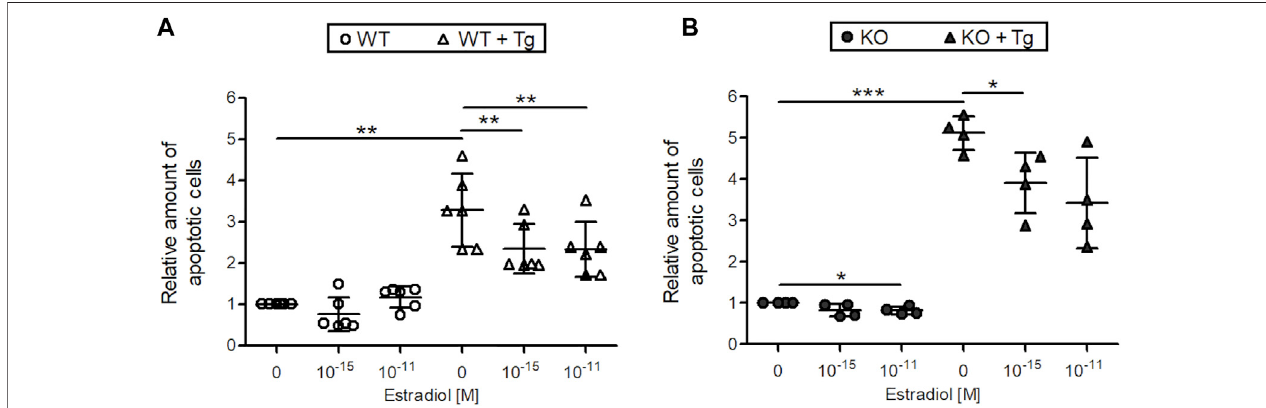
FIGURE2| EstradiolreducesapoptosisinC28/I2WTandERp57KOchondrocytes invitro .C28/I2WT (A) andERp57KO (B) chondrocyteswereculturedfor48 h in presence or absence of 10 µM of the ER stress inductor thapsigargin (Tg) with 0, 10 – 15 and 10 – 11 M estradiol. Cell death ELISA revealed an increased number of apoptotic cells in WT ( p = 0.0133944) and KO ( p = 0.0002630) cell cultures by treatment with Tg. In WT cells + Tg apoptosis was reduced by 10 – 15 M ( p = 0.0193,967) and 10 – 11 M ( p =0.0169453) estradiol. KOcells +Tgalso showed adecreased number ofapoptotic cells by10 – 15 Mestradiol ( p = 0.0245,462). 10 – 11 M estradiol reduced apoptosis as well, but not signi fi cantly ( p = 0.0789,528). Without ER stress induction by Tg estradiol was effective in KO cells with a concentration of 10 – 11 M ( p =